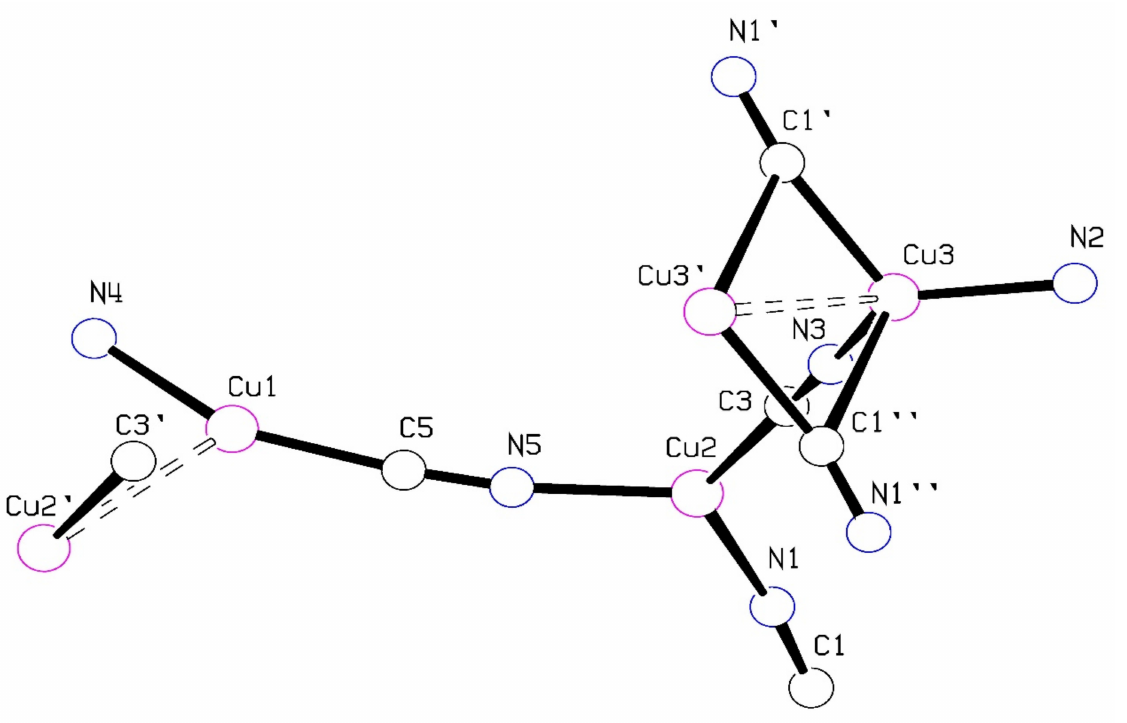
Figure 3. Coordination of the three copper atoms. Primed atoms are related by symmetry. Cuprophilic interactions are shown as dashed